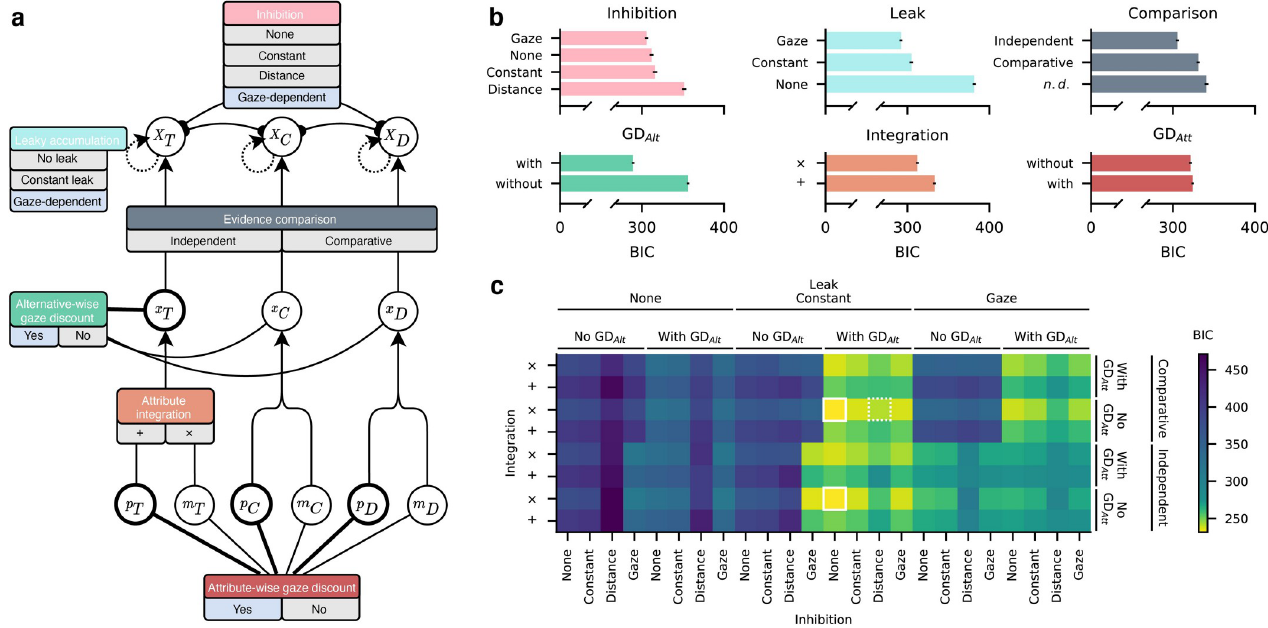
Fig 4. Switchboard analysis. (a) Overview of general switchboard framework and individual switches from which individual variants are constructed by setting the switches to a set of levels. Gaze-dependent switch levels are shaded blue. Attributes can be discounted based on gaze (lower level) and are integrated into alternative values (middle level). Alternative values can be discounted based on gaze, compared, and integrated (upper level) with leak and inhibition. (b) Average model fit associated with each switch’s levels. Each bar shows the average BIC for all model variants that had the respective switch set to this level (e.g., first panel, top bar: average BIC of all variants with gaze-dependent inhibition). Gaze-dependent inhibition and leak, independent evidence accumulation, alternative-wise gaze-discount, multiplicative attribute integration, and no attribute-wise gaze-discount yielded lower BIC on average. (c) Overview of mean BIC for each of 192 model variants. More yellow colours indicate lower BIC and better model fit. The variant with the lowest BIC is identical to the GLA (alternative-wise, no attribute-wise gaze-discount, multiplicative attribute integration, constant leak, and no inhibition) and is outlined in white. The hybrid variant which described 9 participants, mostly with strong attraction effects, best (see main text and Fig 5) has a dotted outline. Note that some variants were mathematically equivalent (see main text and Methods) including the variant with lowest BIC, which is therefore highlighted twice.